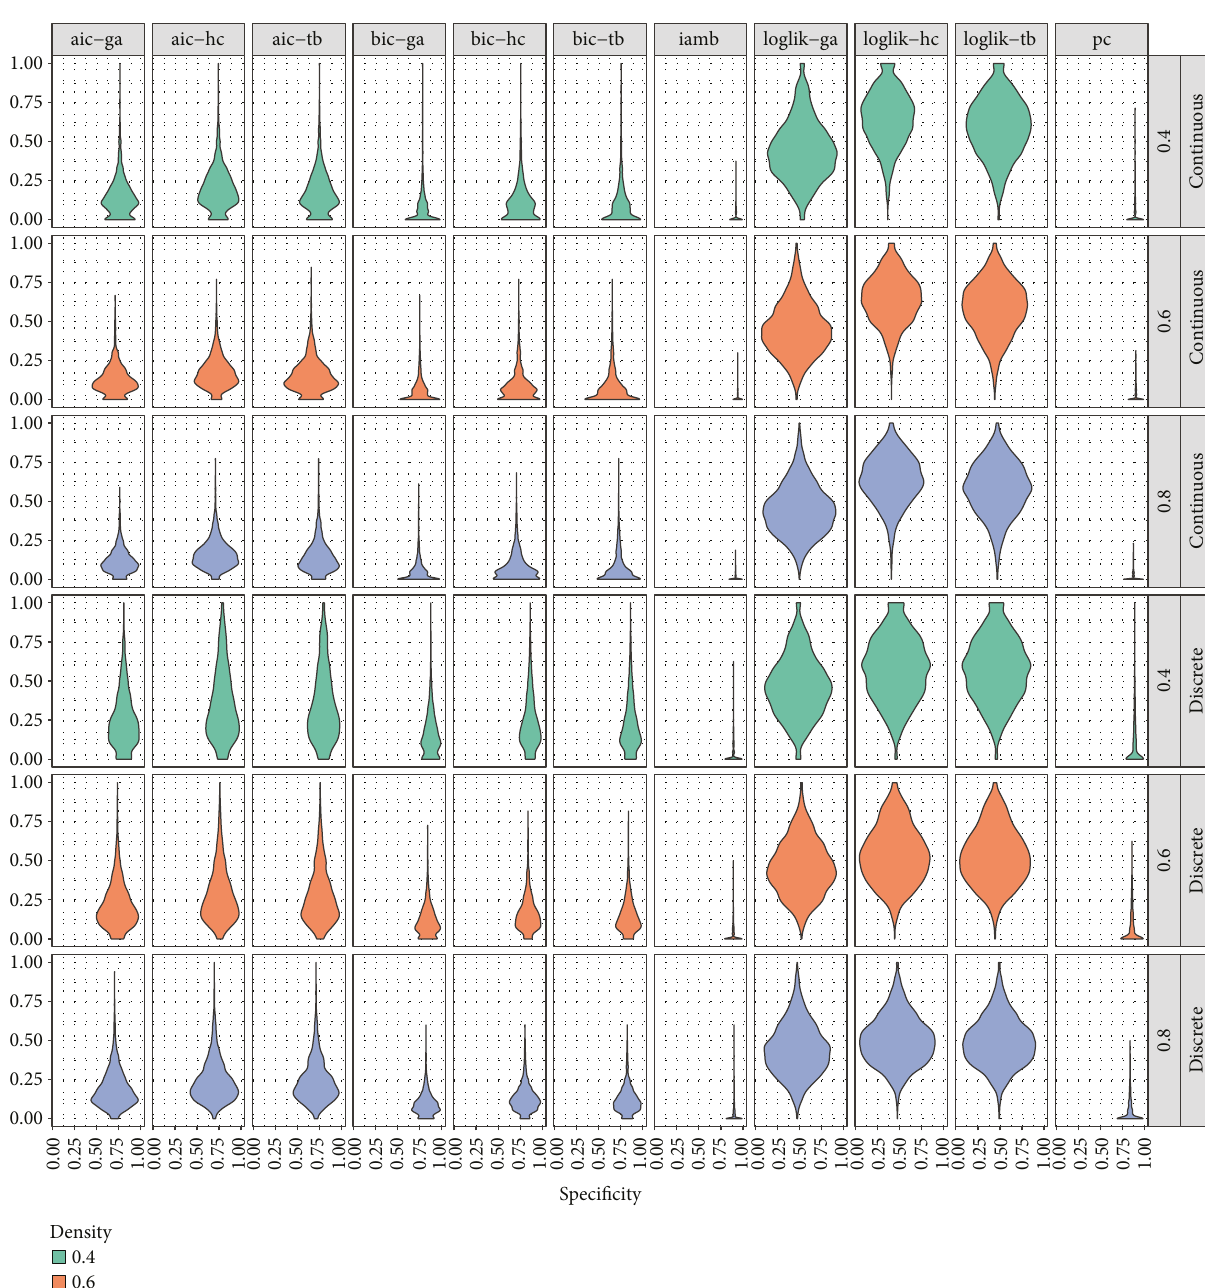
Figure 5: Violin plots showing speci fi city and sensitivity of the solutions obtained by the 11 tested approaches, grouped by the type of dataset (discrete and continuous) and density values (0.4, 0.6, and